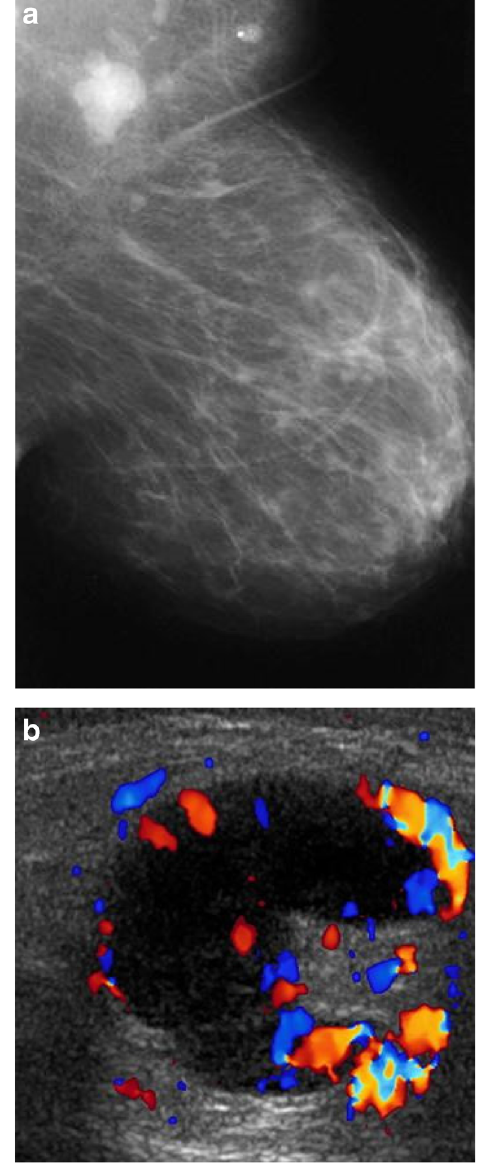
Fig. 11 Cat-scratch disease ( Bartonella henselae ). A 59-year-old woman had a 1-month history of a left axillary mass. Ultrasound-guided biopsy showed follicular hyperplasia with non-necrotising epithelioid granulo- mas. B. henselae (cat-scratch disease) titre was more than 1:1,024, con- sistent with recent infection. a Left mediolateral-oblique view with mag- nified image showed a new left axillary mass ( arrow ). b Ultrasound showed multiple enlarged lymph nodes in the left axilla with lobulated margins, thickened cortices and increased cortical vascular